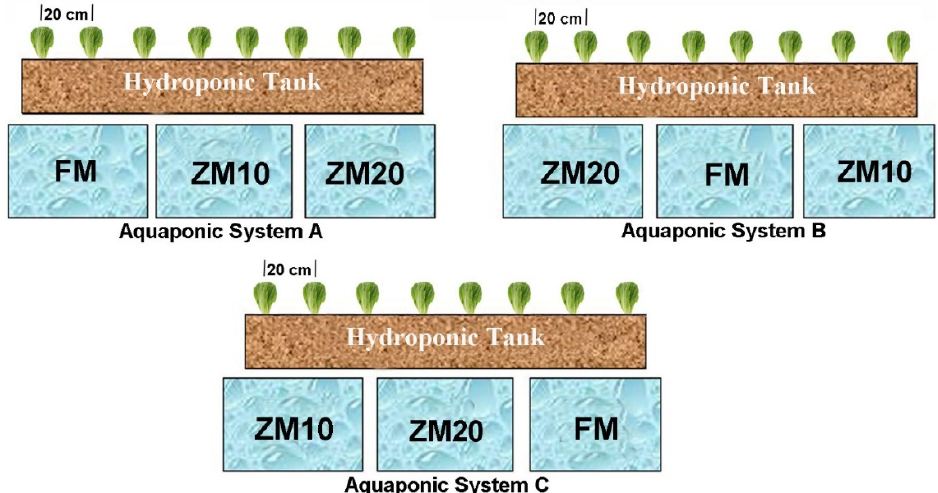
Figure 1. The three aquaponics systems ( A – C ). FM, ZM10, and ZM20 refer to fishmeal, 10% FM replacement with Z. morio meal, and 20% FM replacement with Z. morio meal, respectively.